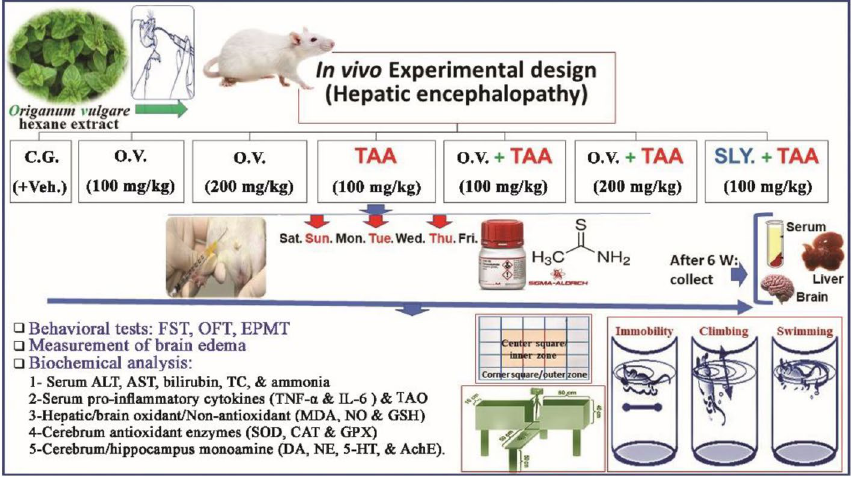
Figure 1. The in vivo experimental design. C.G.: Control group; O.v.: Origanum vulgare, SILY: Silymarin, TAA: Thioacetamide, and Veh.: